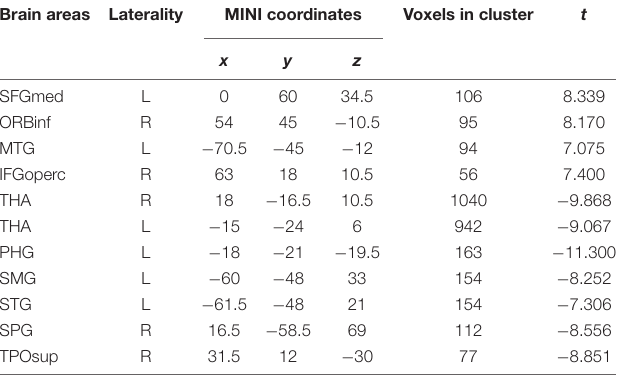
TABLE 2 | Gray matter volume (GMV) abnormalities associated with panic disorder (PD).